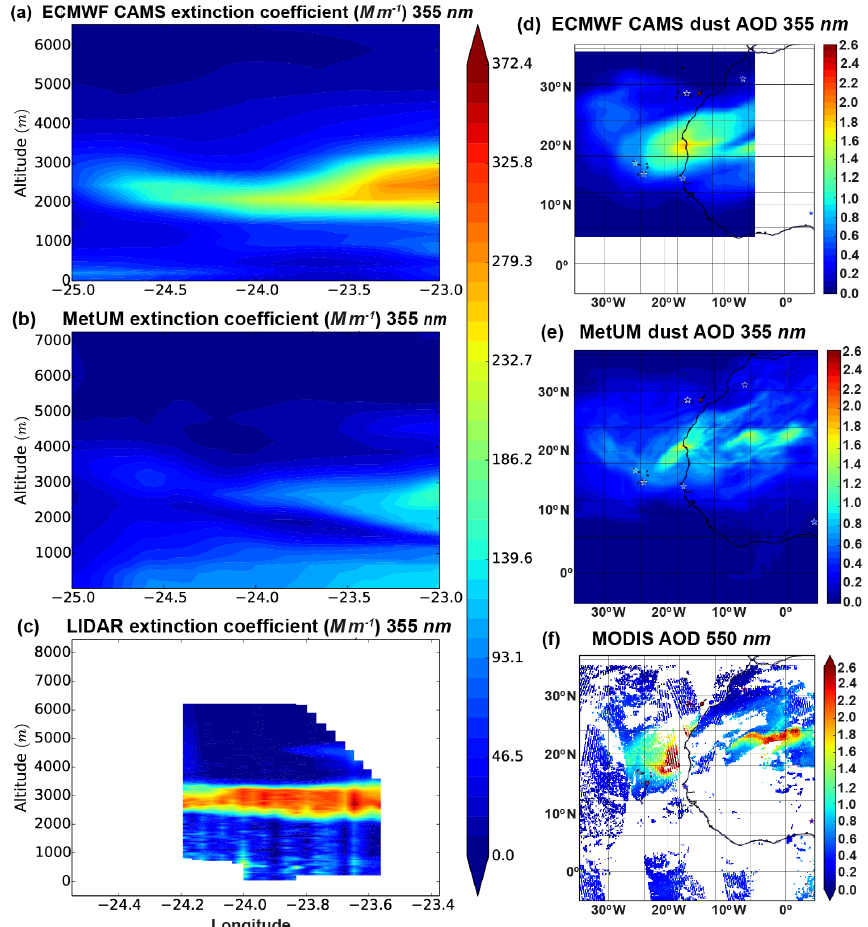
Figure 12. Case study 3, B927, 15 August, R1: (a–c) vertical cross section along the flight track showing the aerosol extinction coefficient for ECMWF–CAMS (a) , MetUM (b) , and the aircraft lidar (c) ; the colour scale is the same for these three plots. (d) ECMWF AOD map, (e) MetUM AOD map, and (f) AOD map from combined observations from MODIS, AERONET (stars), and aircraft lidar